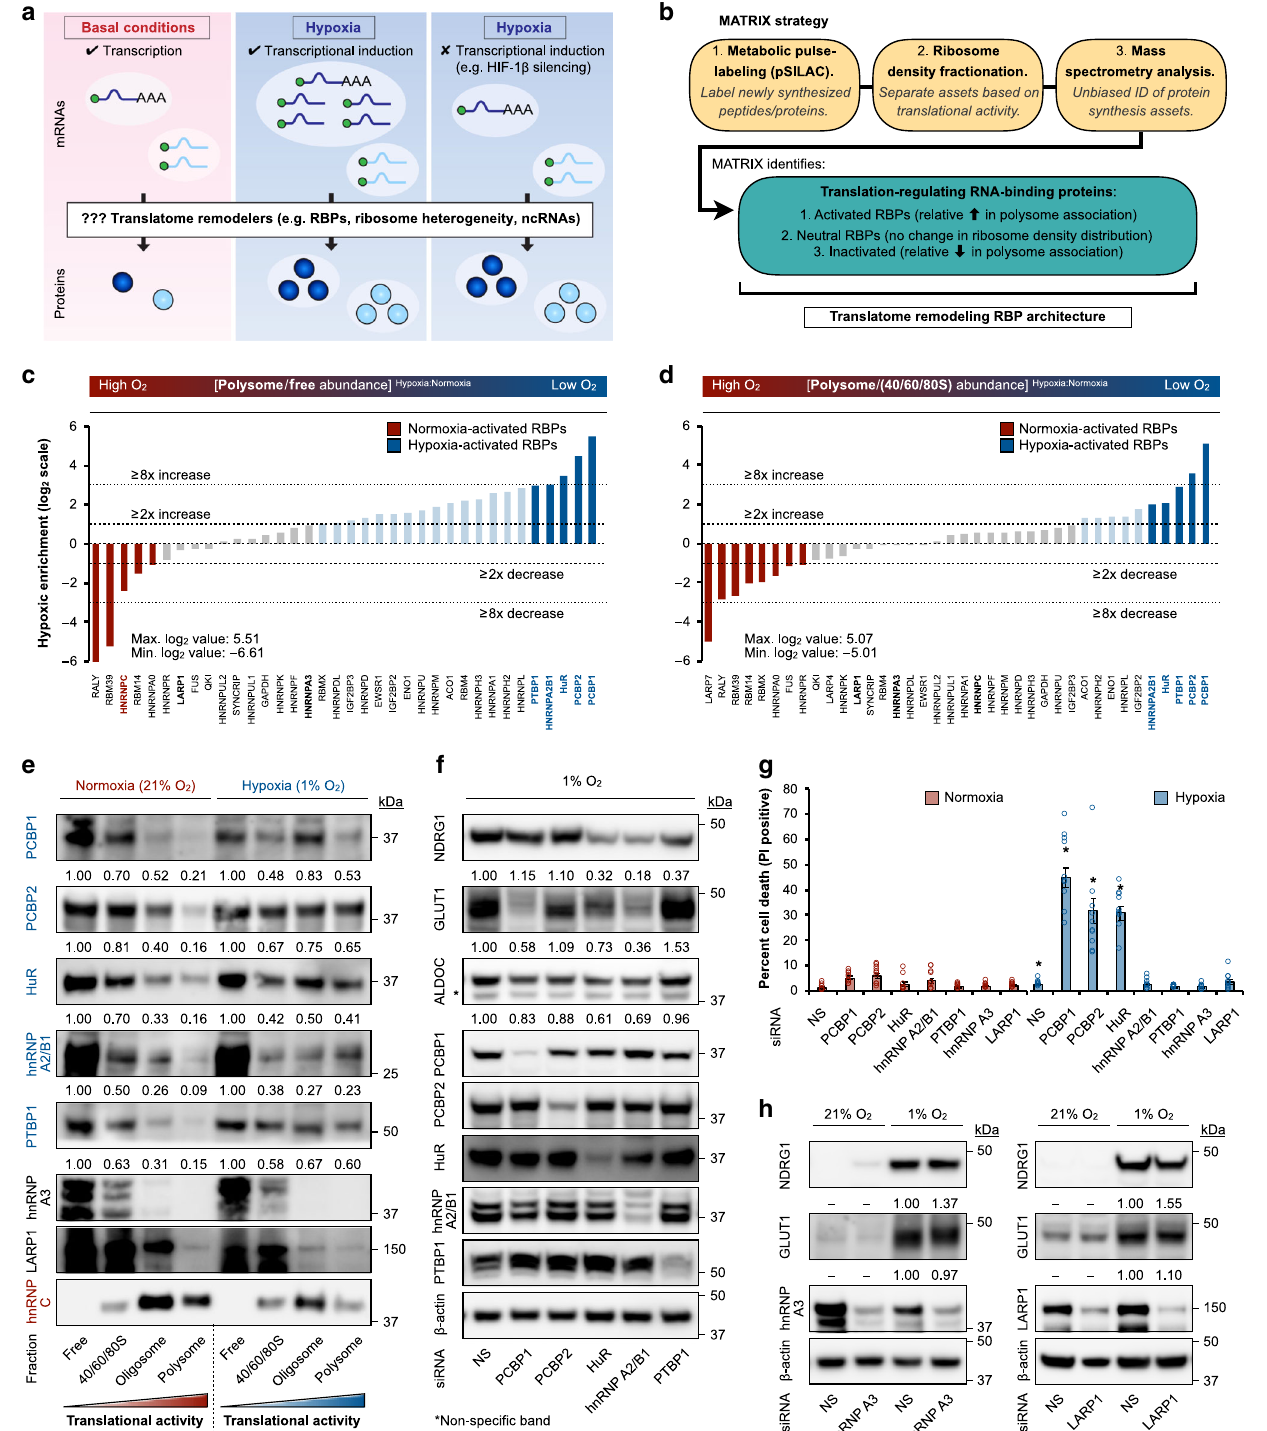
regulated by an array of RBPs that may exert collaborative or competing effects. Likewise, even though PCBP2 silencing did not appear to alter the steady-state protein levels of the three repre- sentative targets shown, this does not preclude its role in reg- ulating other hypoxia-inducible proteins/pathways. Notably, cell death (Fig. 1g, Supplementary Fig. 2c, d) and cell viability (Sup- plementary Fig. 2e) measurements revealed a signi fi cantly greater effect of hypoxia-adaptive/oxygen-sensitive RBPs e.g.